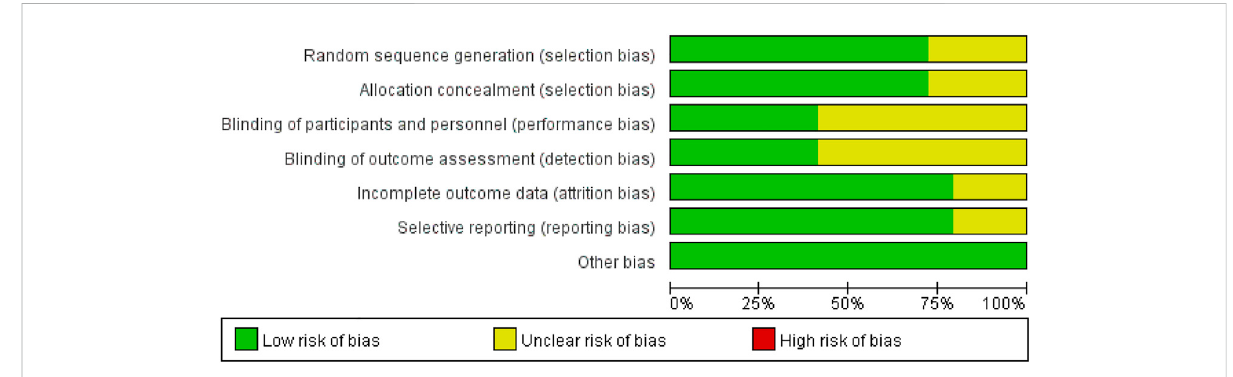
FIGURE 2 The risk of bias and quality evaluation score (%) per risk of bias item.